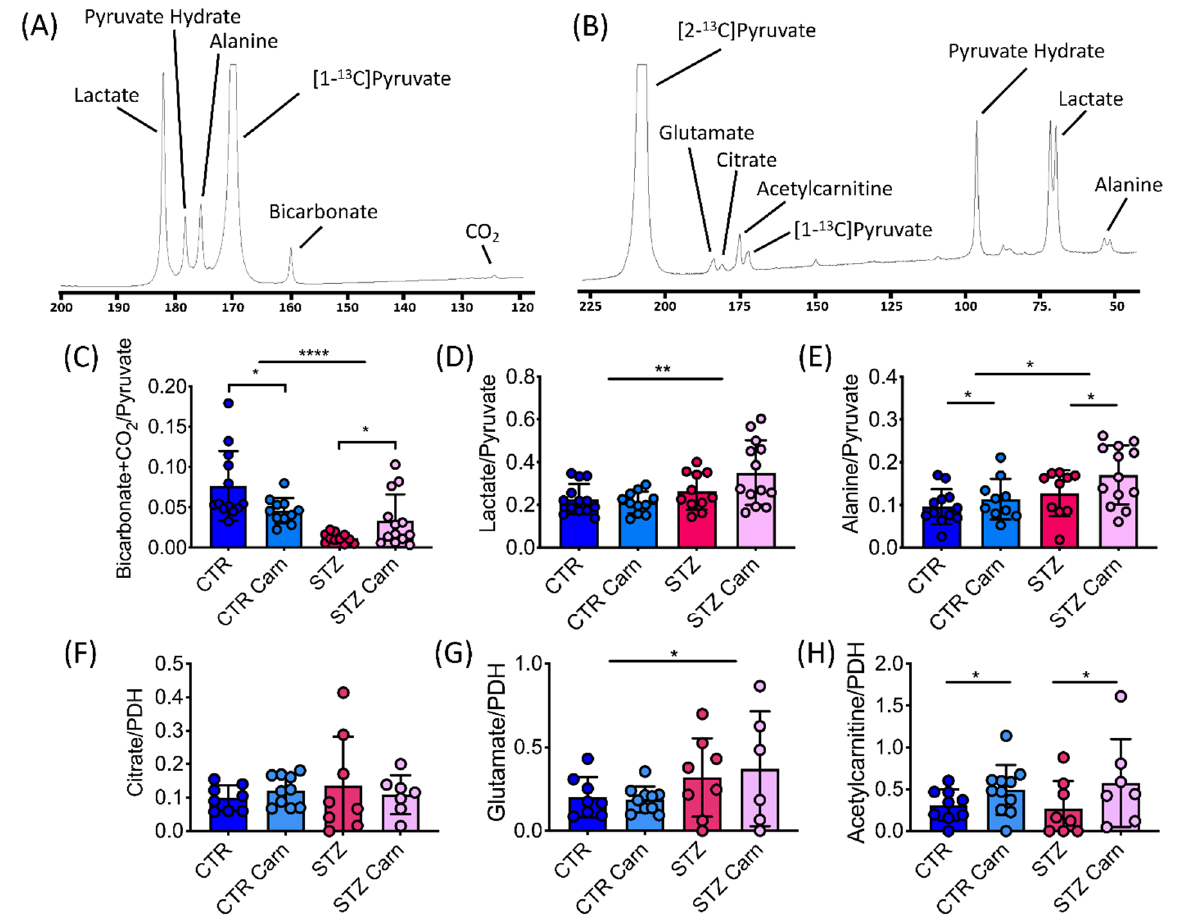
Figure 3. Carnitine can modulate in vivo cardiac metabolism. In vivo effects on cardiac metabolism by infusion of hyperpo- larized [1- 13 C]pyruvate and [2- 13 C]pyruvate. ( A ) Example [1- 13 C]pyruvate spectrum acquired from the in vivo rat heart. ( B ) Example [2- 13 C]pyruvate spectrum acquired from the in vivo rat heart. ( C ) Bicarbonate + CO 2 /pyruvate ratio, as a mea- sure of pyruvate dehydrogenase (PDH) flux. ( D ) Lactate/pyruvate ratio. ( E ) Alanine/pyruvate ratio. ( F ) Citrate/pyruvate ratio normalized to PDH flux. ( G ) Glutamate/pyruvate ratio normalized to PDH-flux. ( H ) Acetylcarnitine/pyruvate ratio normalized to PDH-flux. Data are presented as mean ± SD. Two-way ANOVA, if an interaction was found to be significant, the effect of L-carnitine on control and diabetes was evaluated using Sidak’s multiple comparison test. Significant differences are represented by ‘*’, with * p < 0.05, ** p < 0.01, **** p <